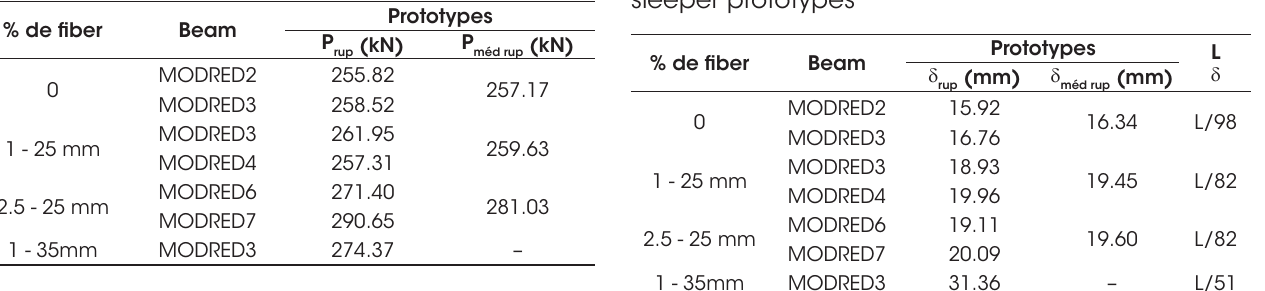
Prediction failure load of the sleeper prototypes Vertical displacement on failure of